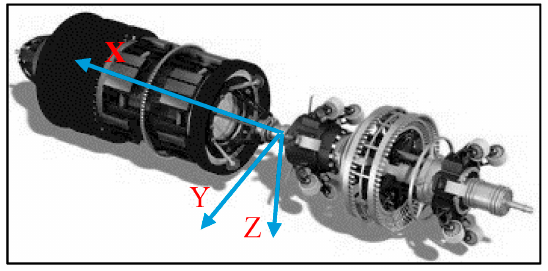
Figure 8. Pig defined axes.